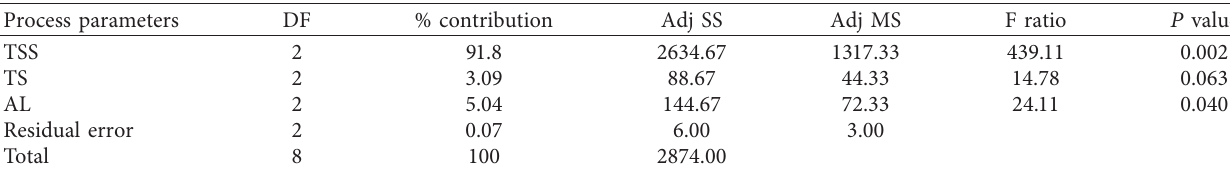
Table 6: ANOVA outcomes for tensile strength.